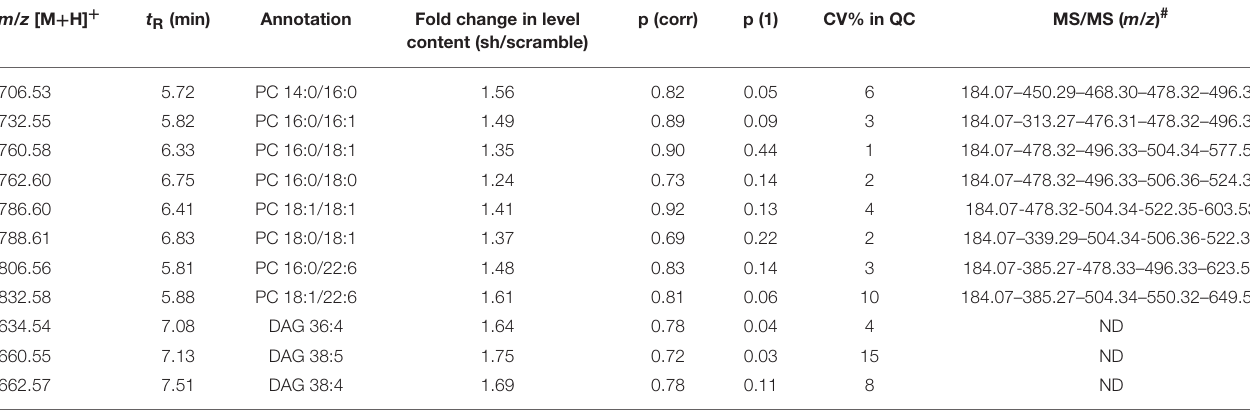
TABLE 1 | Discriminative lipid species whose detected levels in AAV-shCYP46A1 4 weeks after injection are higher than in the control (AAV-scramble) predicted by OPLS-DA obtained from positive ion mode data set. m/z [M + H] +